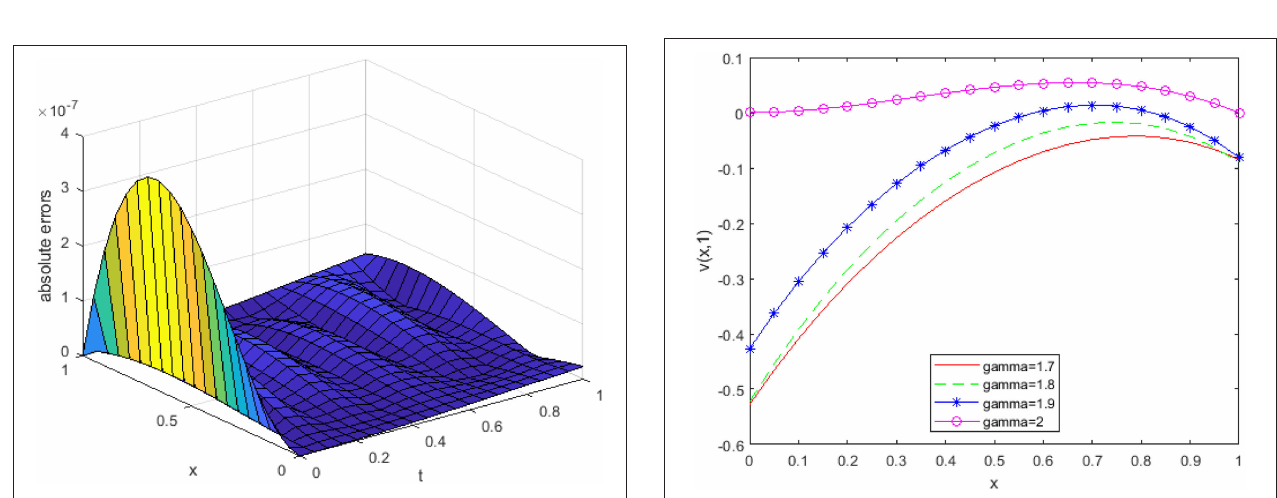
FIGURE 9 | Approximate solution at different values of x and γ at t = 0.5.